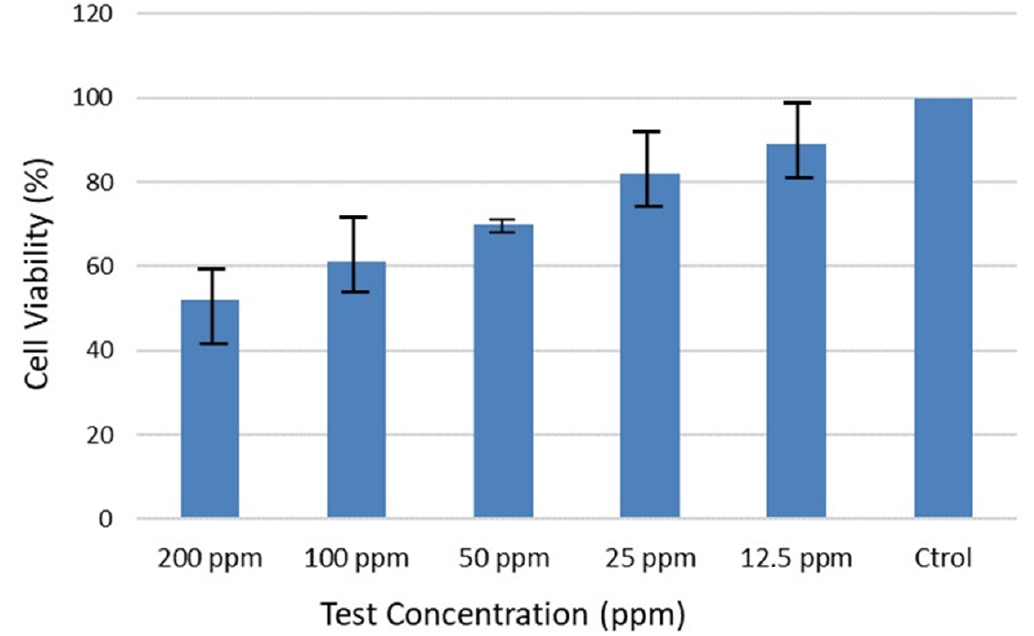
Figure 11. Effect of graphene on the generation of cytotoxic effects in human skin fibroblast cells. Concerning the Caco-2 cell line, the cell viability also showed a dose-dependent pattern for pristine graphene in the concentration range from 6.25 to 100 ppm, with a first effect at a concentration higher than 12.5 ppm (cytotoxicity above 60%), which indicates a low to moderate toxicity potential of graphene in this cell-free system. This dose-dependent effect of the particles can be found in Figure 12, where the effect of the particles over time at different doses is depicted. For example, for 100 ppm of graphene, the cell viability calculated was 46.33% after 24 h of exposure. This means that the cytotoxic potential for the oral route is higher than the one observed for the A549 cell line.